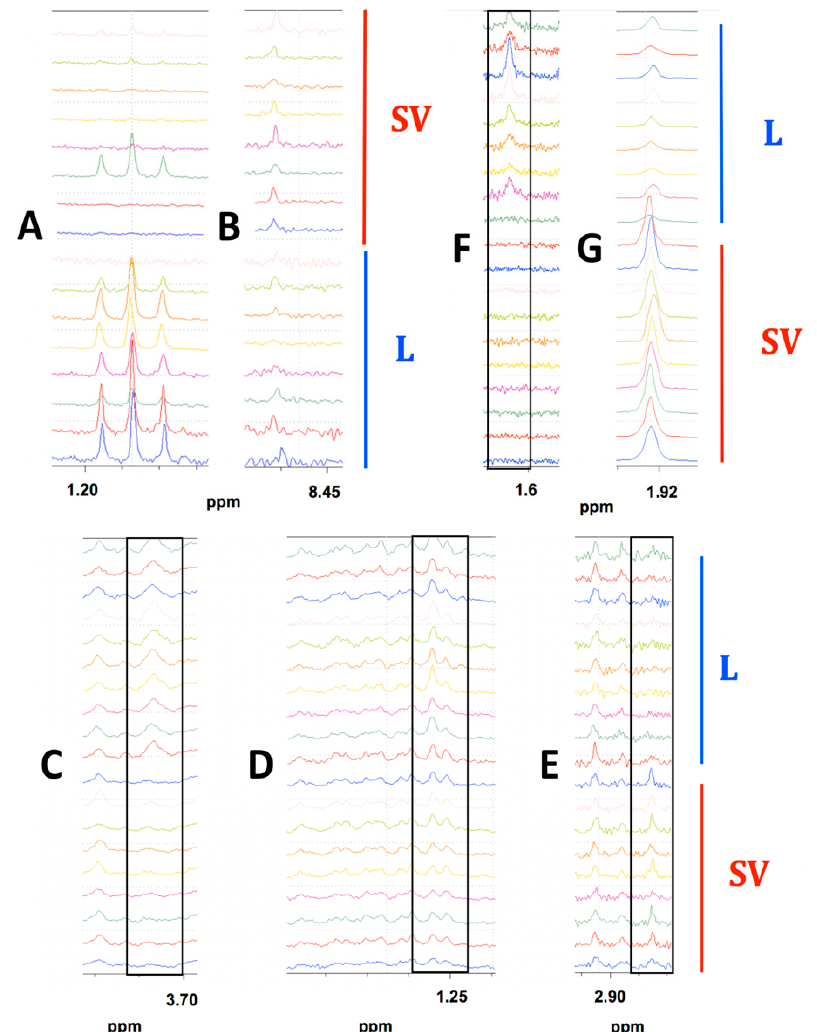
Figure 3. Highlighted spectral differences observed in MiaPaCa-2, Panc-1 and AsPC-1 cell extract comparisons depending on the drying method used for sample preparation. ( A ) Ethanol present in the lyophilized MiaPaCa-2 samples only. ( B ) Formic acid present in both groups of MiaPaCa-2 cell extracts but at higher concentration in SpeedVac samples. The bottom eight spectra were lyophilized samples (L) and the top eight spectra were SpeedVac samples (SV). ( C ) Leucine present only in the lyophilized Panc-1 samples. ( D ) Isoleucine present in both groups of Panc-1 cell extracts but at a higher abundance in the lyophilized samples. ( E ) Trimethylamine present only in SpeedVac dried Panc-1 samples. The bottom nine spectra were SpeedVac samples (SV) and the top 10 spectra were lyophilized samples (L). ( F ) N-methyl- α -aminobutyric acid present only in the lyophilized AsPC-1 samples. ( G ) Acetate was present in both groups but at a higher concentration in SpeedVac samples. The bottom nine spectra were SpeedVac (SV) samples and the top 10 spectra were lyophilized samples (L). Peaks of interest are boxed in each comparison of stacked spectra.